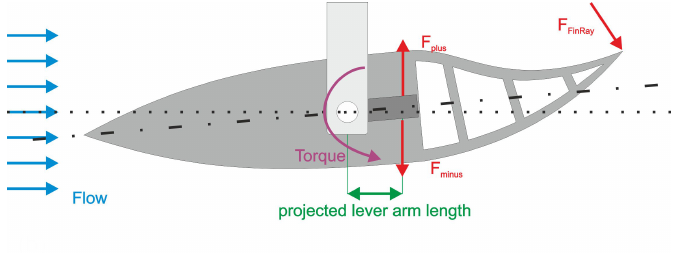
Figure 5. Measurement setup. The boat was deflected by 5 ◦ to measure the forces F plus and F minus by means of two strain gauge measurement